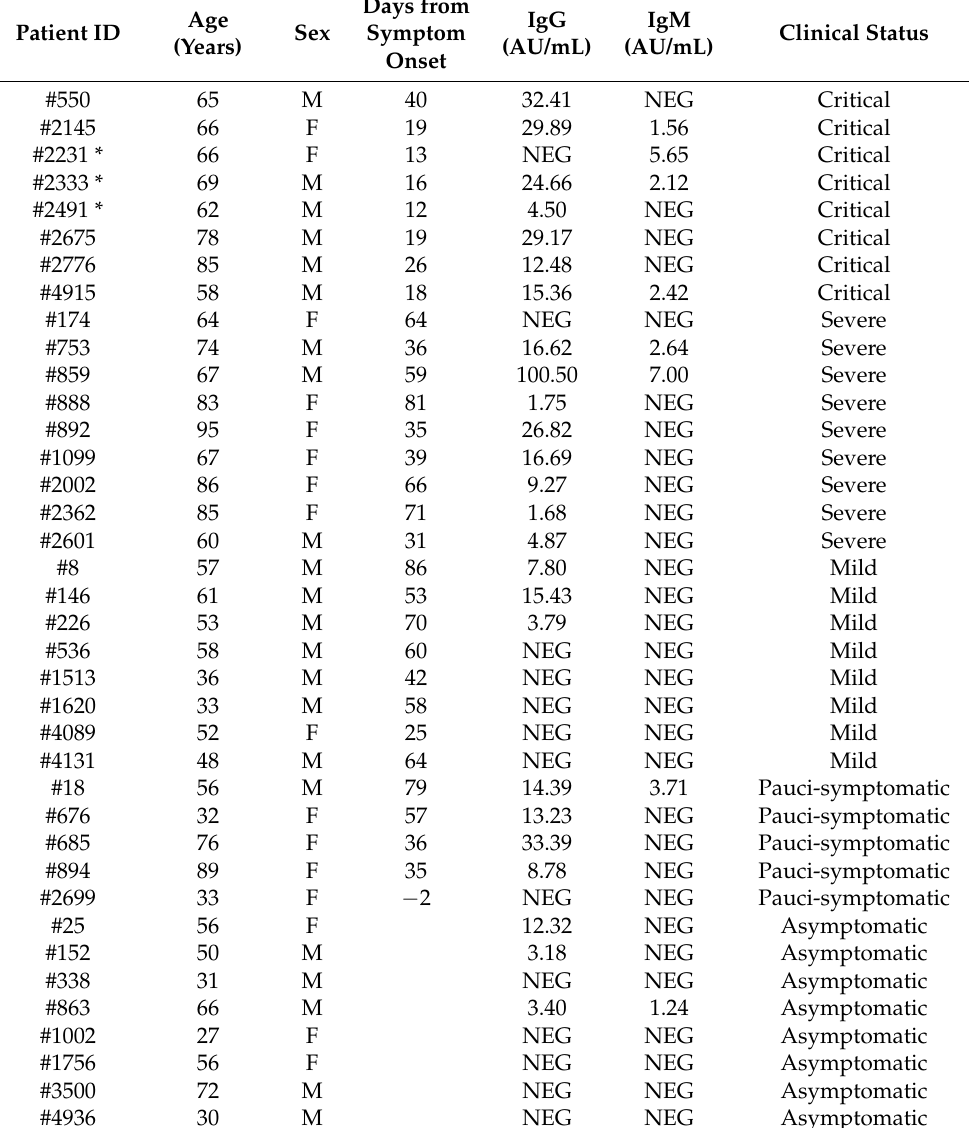
Table 2. IgG and IgM titers in COVID-19 patients who underwent serological test only